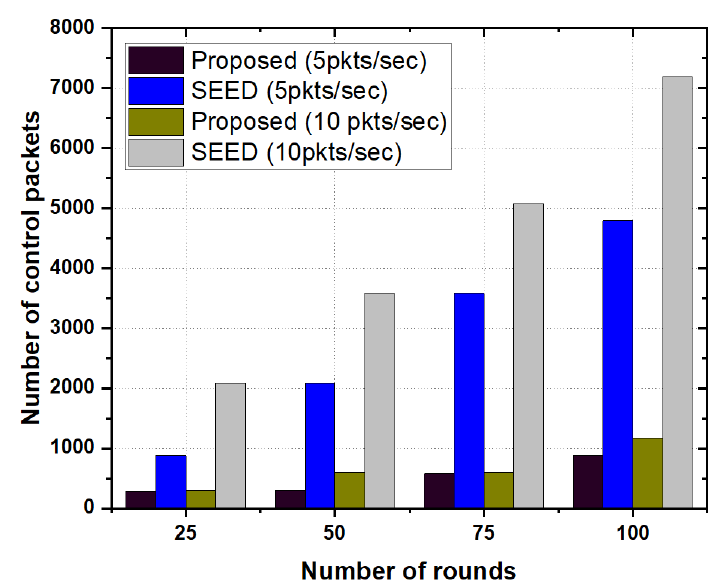
Figure 7. Number of control packets as a function of the number of rounds.